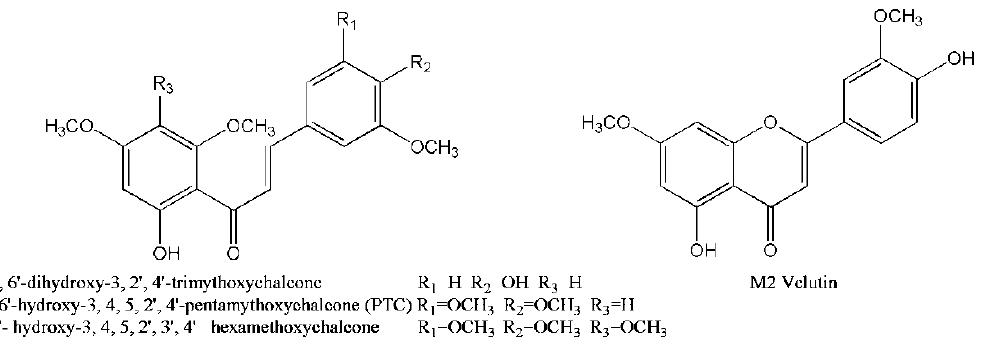
Figure 3. Chemical structures of the reference standards.